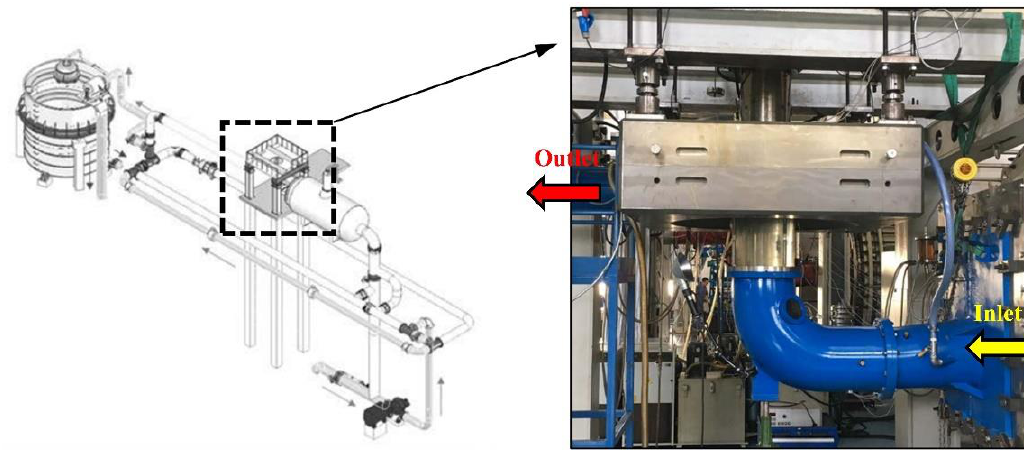
Figure 5. Scheme of the test rig in HILEM.